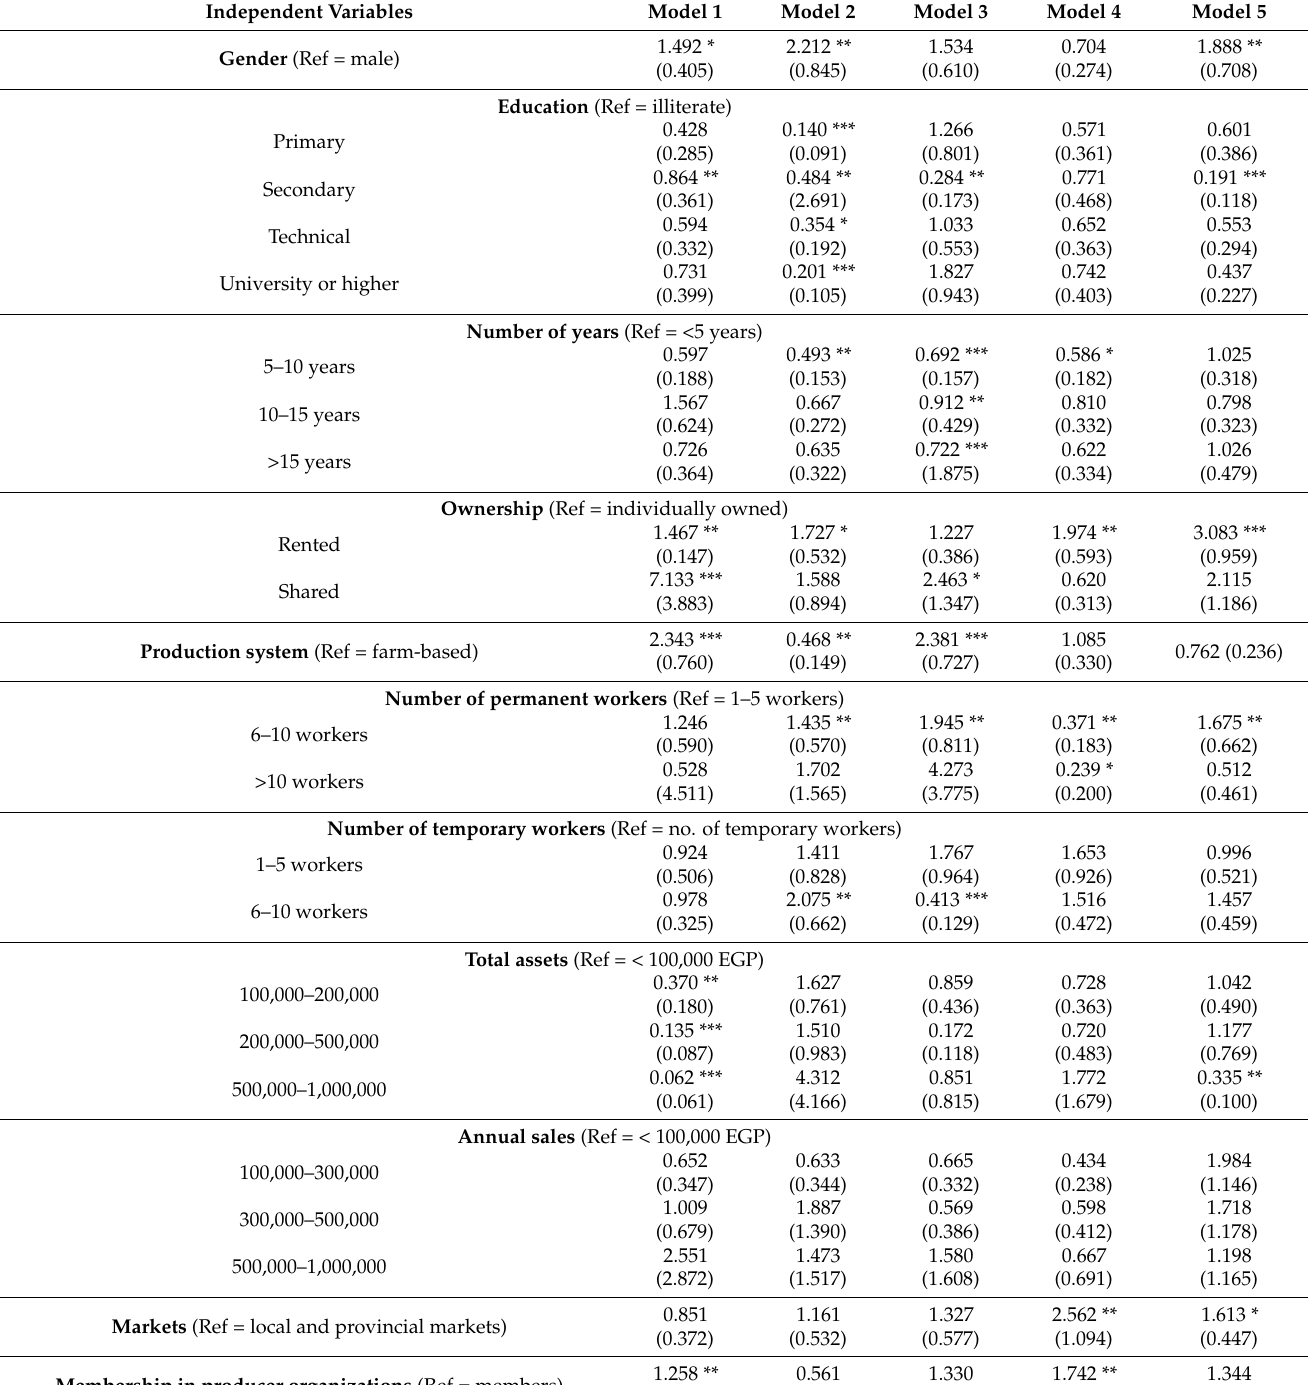
Table 5. Calculated odds ratio of the explanatory variables in the ordered logit models examining the determinants of COVID-19 impacts on the farms